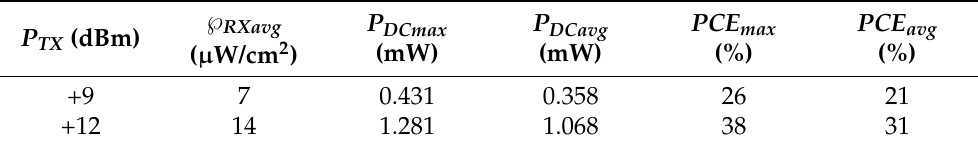
Table 5. 2 × 2 Rectenna Array Measurements (2.40–2.48 GHz Band).